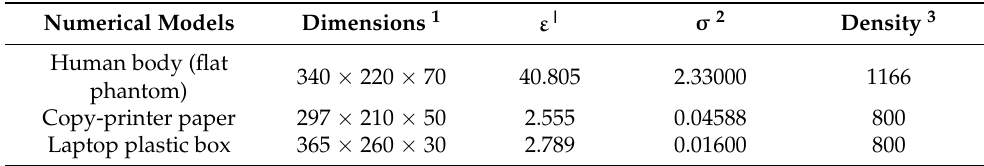
the performance of the proposed